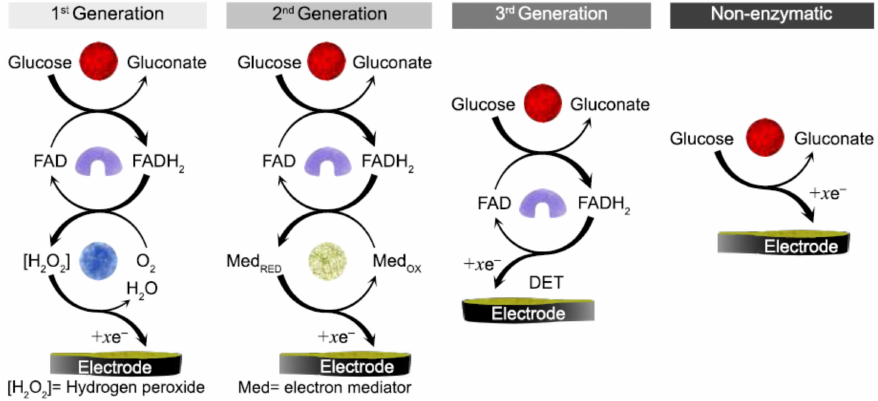
Figure 7. Electrochemical PBGS: First generation, second generation, third generation and